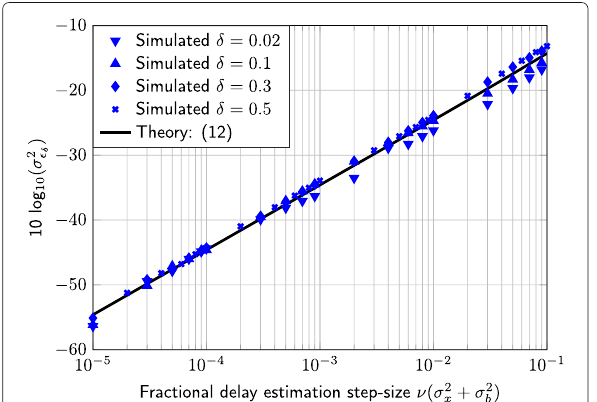
Fig. 6 Theoretical and simulated error delay variance versus the fractional delay estimator step-size